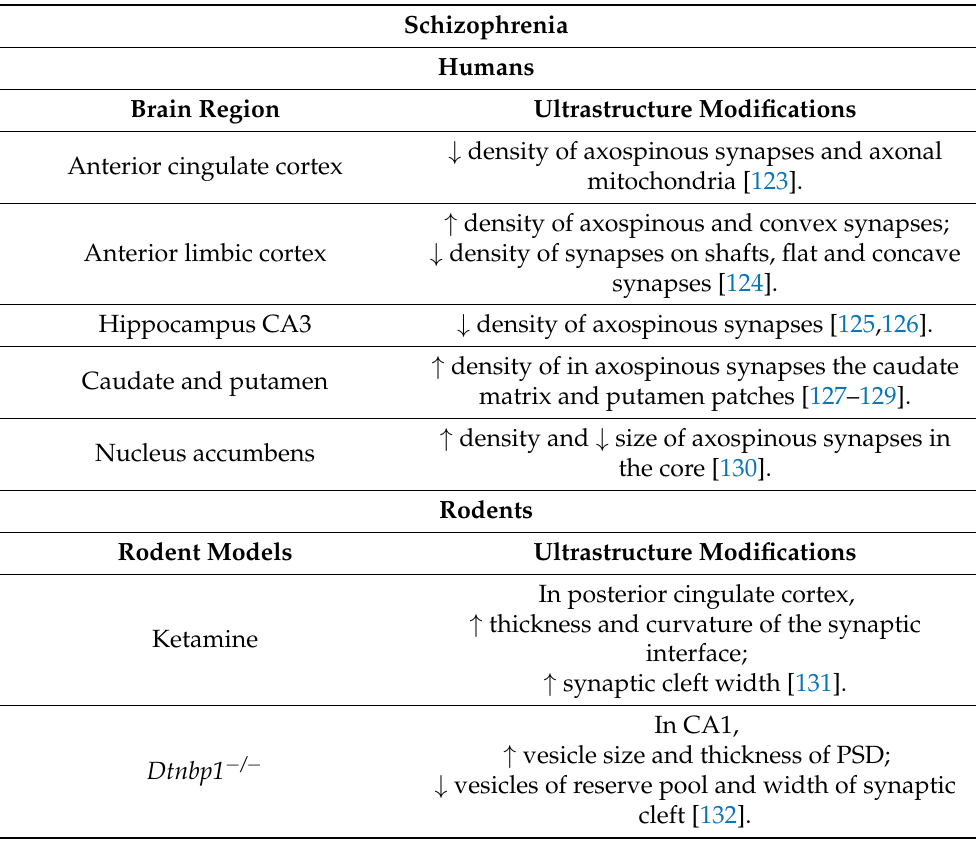
Table 1. Synaptic ultrastructural alterations in schizophrenia. Different studies have assessed the synaptic ultrastructural changes of synaptic transmission in schizophrenia in postmortem human tissues and rodent models (either chemical or genetic). The affected proteins are shown in Figure 1. ↑ stands for increased, ↓ stands for decreased. CA1: Cornu ammonis area 1, CA3: Cornu ammonis area 3, PSD: postsynaptic